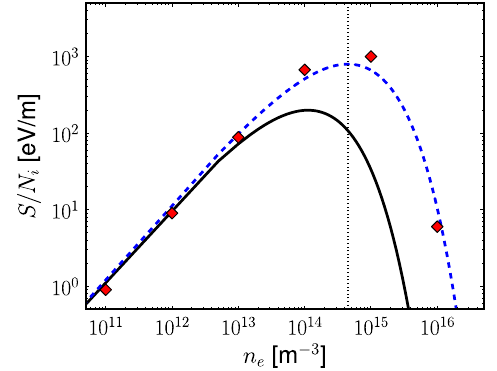
FIG. 4. Electron cloud density contour obtained from the tracking simulation for a larger number of particles per bunch ¼ 10 13 . The initial electron cloud charge density (cid:2) N i with n e ¼ 10 12 m (cid:2) 3 , is used to normalize the color scale.